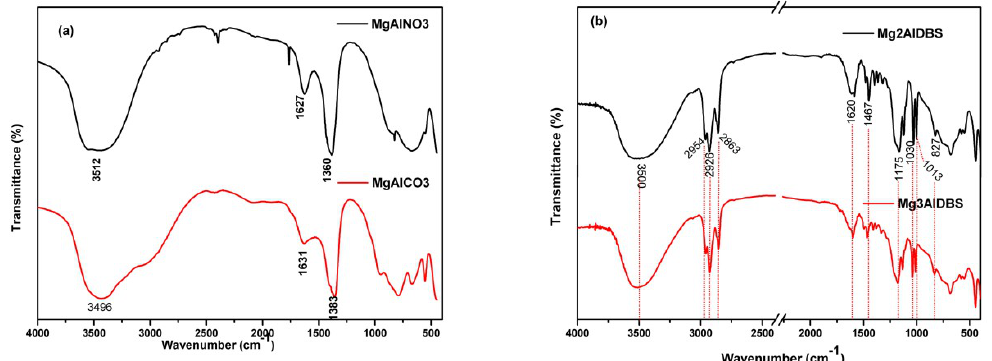
Figure 2. FT-IR spectra of the synthetized adsorbents: ( a ) MgAlCO3 and MgAlNO3 LDH samples; ( b ) Mg2AlDBS and Mg3AlDBS nanohybrids’ samples.